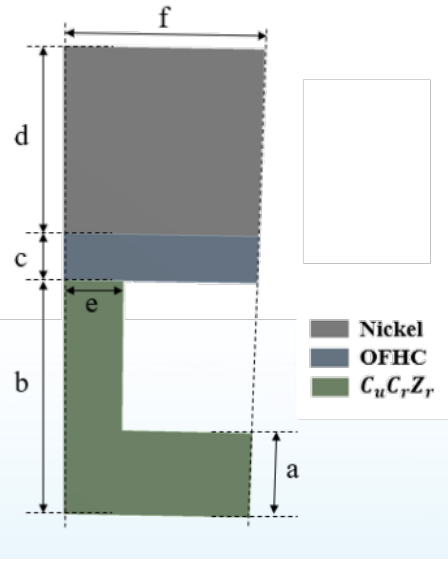
Figure 6. Cooling channel section. Table 2. Physical and thermal properties of CuCrZr [16].